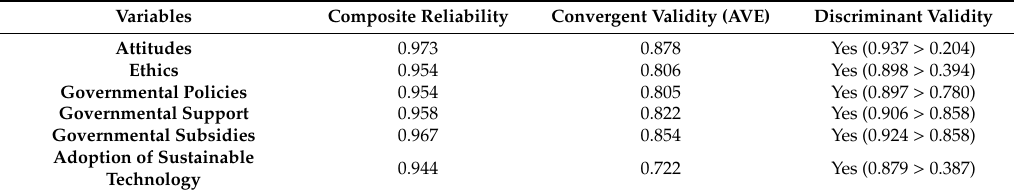
Table 2. Validity and reliability of the